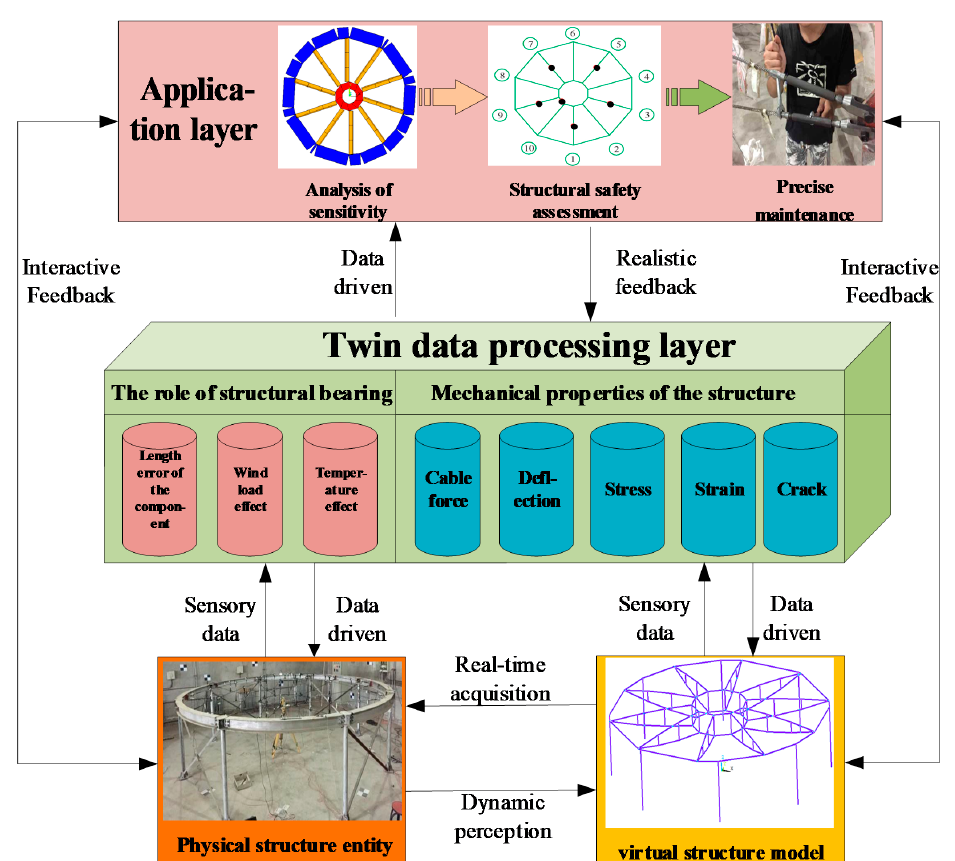
Figure 2. Multidimensional model for intelligent discrimination of sensitivity to mechanical parameters of cables.